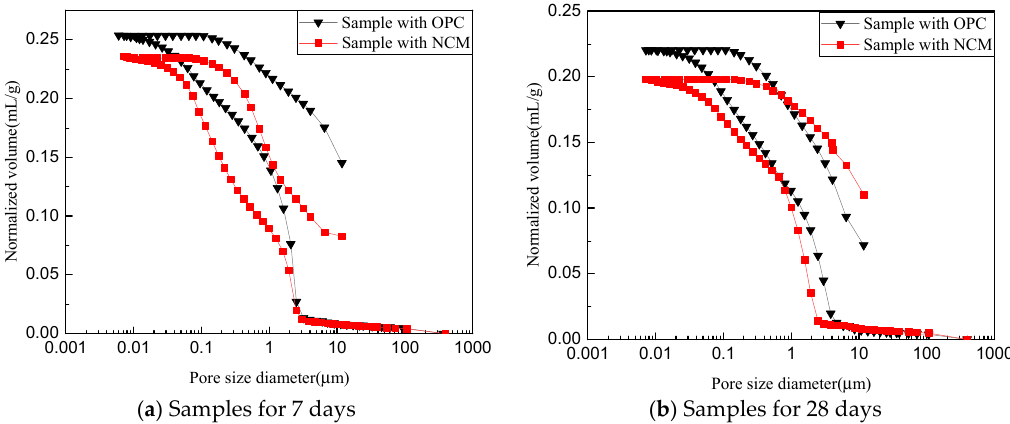
Figure 13. The intrusion and extrusion curves for samples with different cement materials and curing time.